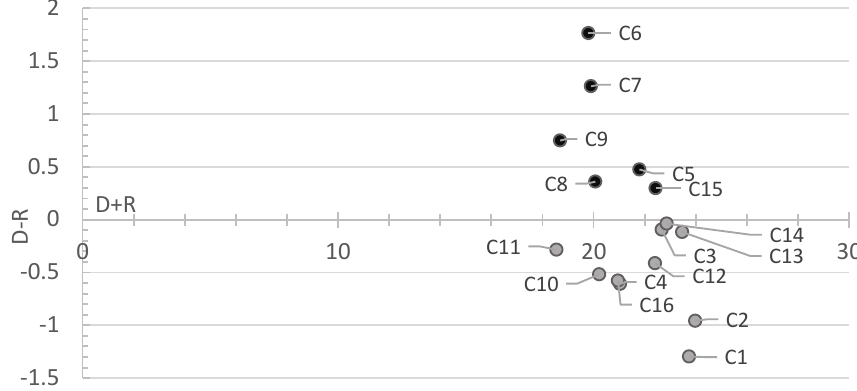
Figure 2. Cause-and-effect relationship diagram.